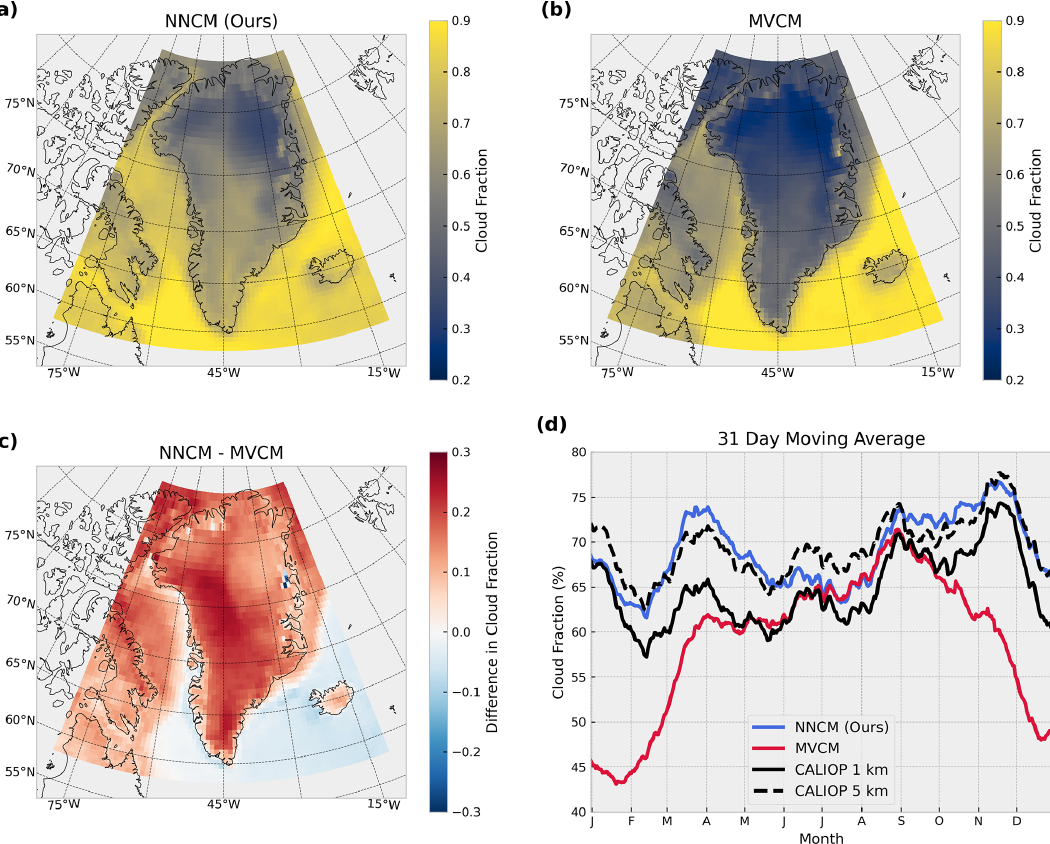
Figure 13. Regional analysis of cloud fraction over Greenland. Panels (a) and (b) illustrate the mean cloud fraction for the NNCM and the MVCM for all selected VIIRS scenes in 2019. Panel (c) is the difference between (a) and (b) . Panel (d) is the domain-wide 31d moving average of grid points spatially matched with CALIOP (see main text for